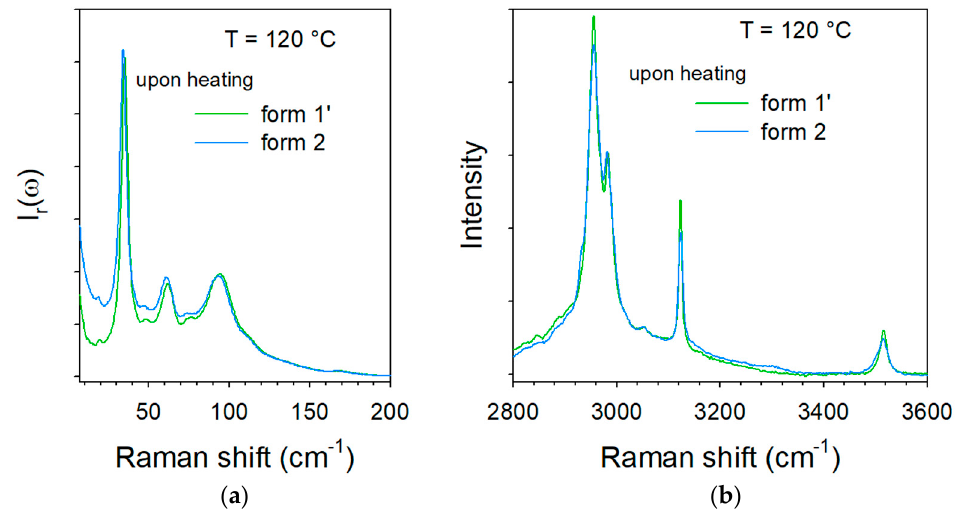
Figure 5. Raman spectra collected at 120 °C upon heating the two pseudo polymorphic forms 1 ′ and 2 ( a ) in the low-frequency region, ( b ) in the C–H and O–H stretching region.